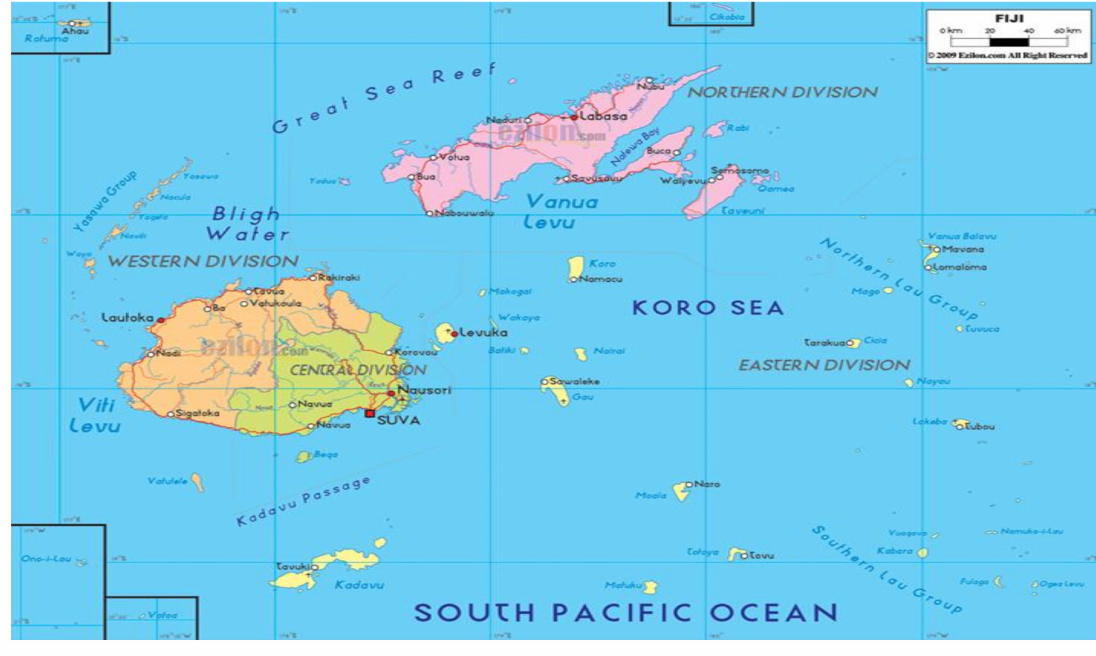
Figure 1. Map of